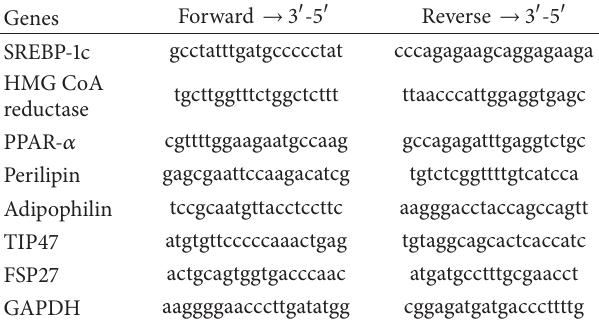
Table 1: List of primers used in the